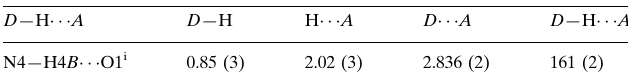
Hydrogen-bond geometry (A˚ , (cid:1)